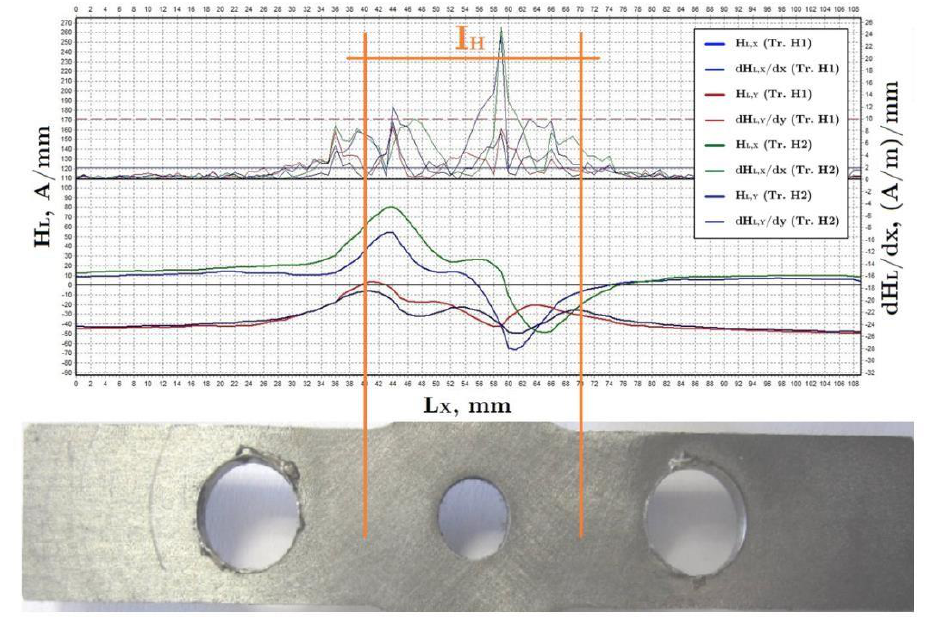
Figure 14. Magnetogram of the trajectories H1 and H2 in the specimen DC5.